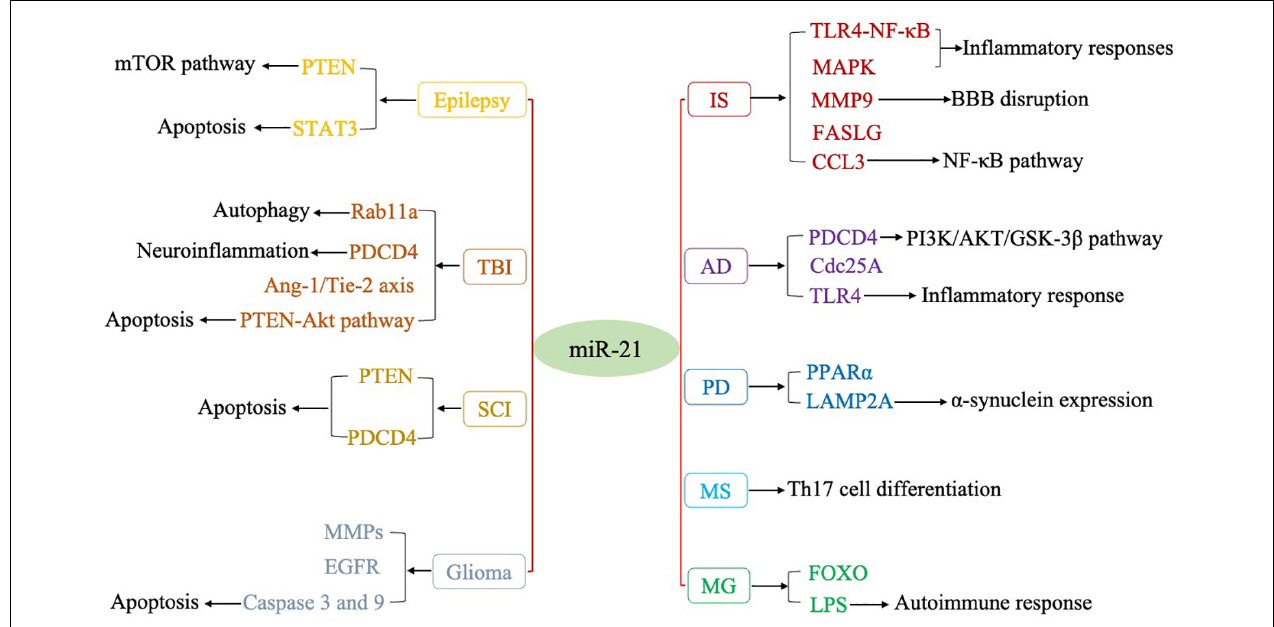
FIGURE 1 | Regulatory targets of miR-21 in various CNS